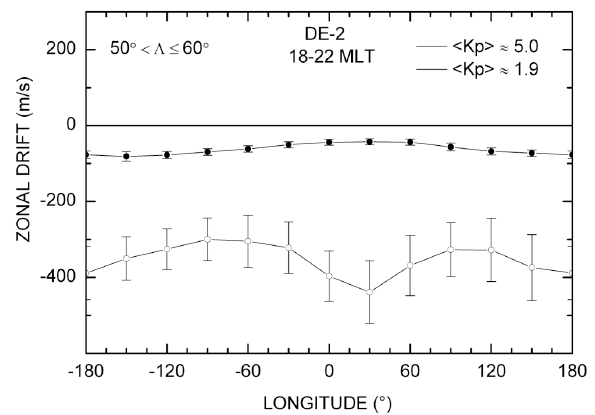
Fig. 10. Longitudinal dependence of quiet ( Kp ≤ 3) and disturbed ( Kp> 4) zonal drifts velocities at upper middle latitudes. The scatter bars denote the standard deviations.